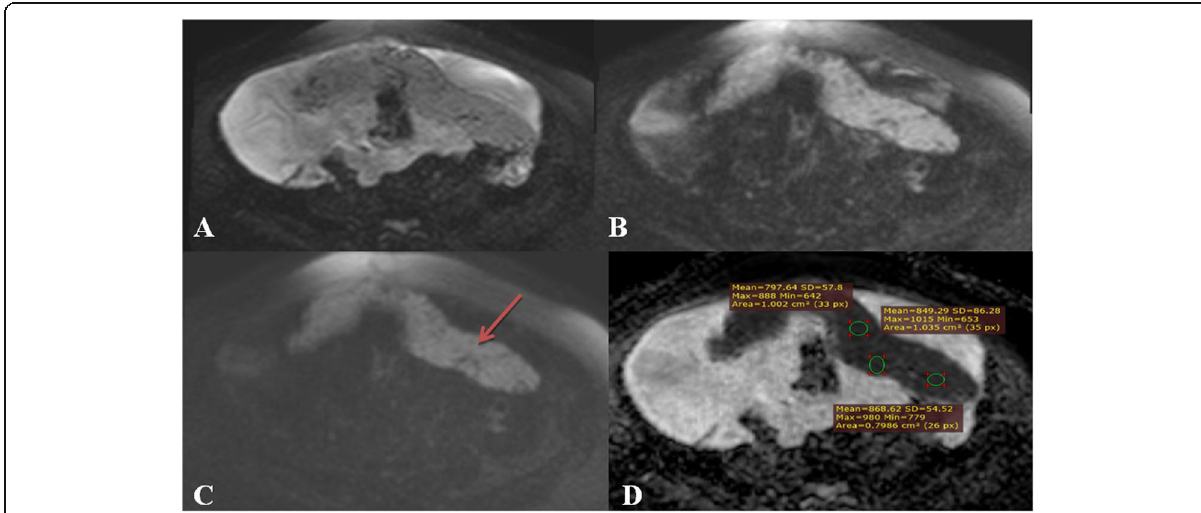
Fig. 5 Forty-nineyears old male patient, with abdominal pain and distension, a peritoneal mass was detected during abdominal ultrasound. a DWI at b 0. b DWI at b 500. c DWI at b 1000. d ADC map. The images showed a large irregular solid peritoneal mass lesion with high signal in DWI and low in ADC map, impressive of restricted diffusion with average ADC value 0.5 ± 0.02 × 10 − 3 mm 2 /s. Final diagnosis after pathological examination was peritoneal sarcomatosis